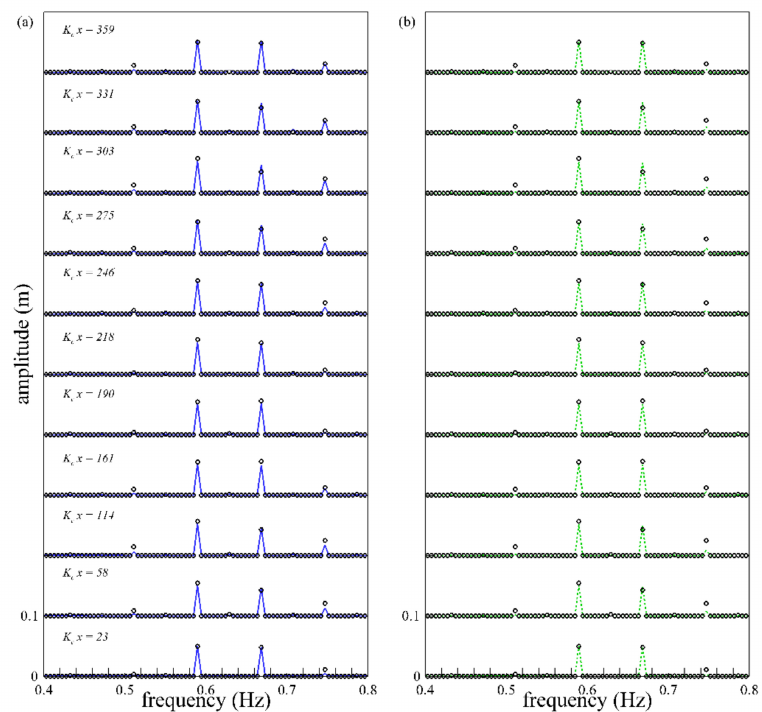
Figure 12. Same as Figure 10 , except for non-linear bi-chromatic waves (case B11): ( a ) FNHS results and ( b ) QNHS